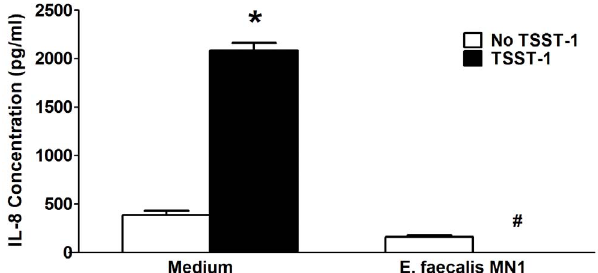
Figure 2. E.faecalis MN1 inhibits the IL-8 response of HVECs to the staphylococcal superantigen TSST-1. E. faecalis MN1 (1 6 10 7 CFU) was incubated with HVECs in the absence and presence of TSST-1 (100 m g/ml) for 6 h. Cell culture supernates were collected and IL-8 was measured by ELISA. *Significantly higher than all other conditions and # significantly lower than medium only control by one-way ANOVA [ F (3,29)=251.2, p , 0.0001] and Tukey’s post-hoc test. N=3–6 replicates.